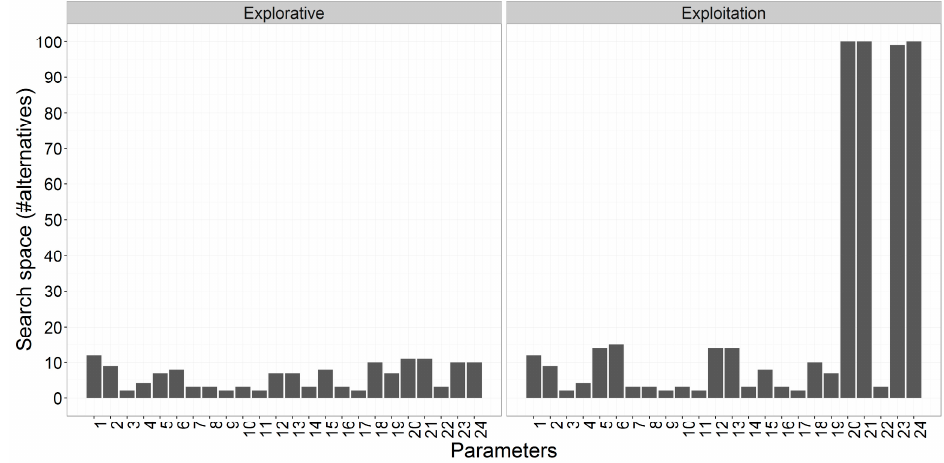
Figure 10. Search space size allowed for the explorative and exploitation modes.